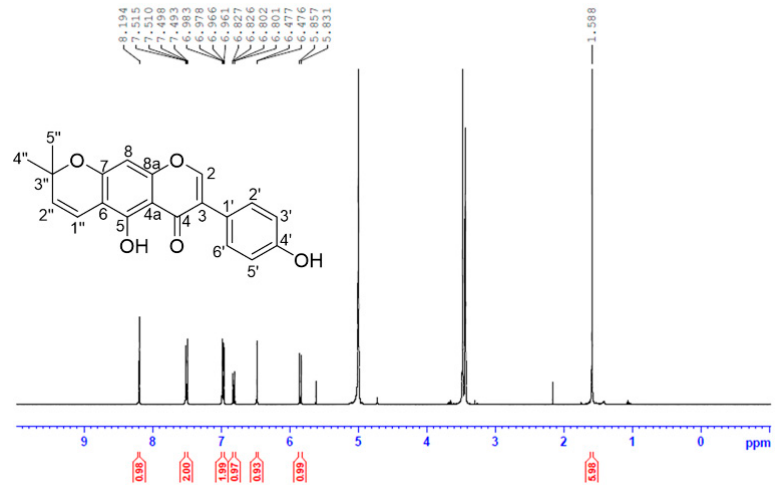
Figure 3. Isolation and nuclear magnetic resonance (NMR) imaging analysis of alpinumisoflavone (AIF) extracted from unripe fruits of Cudrania tricuspidata.